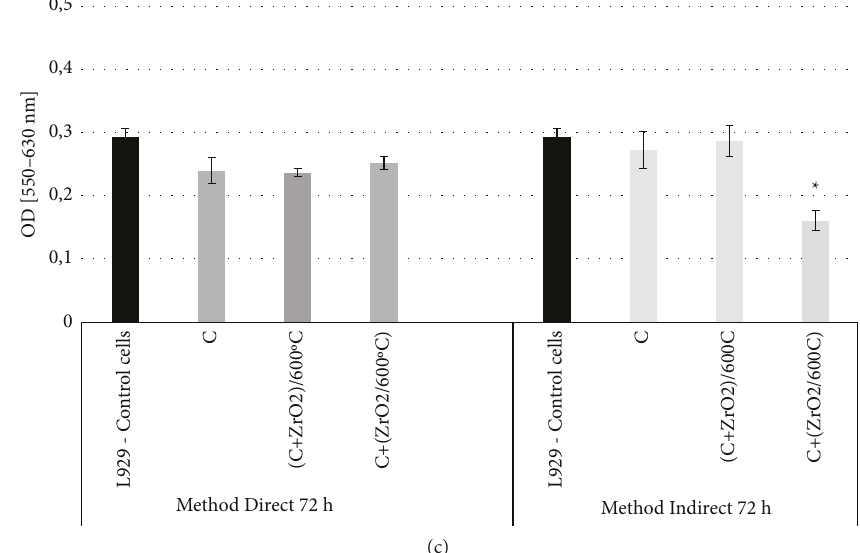
Figure 5: The cytotoxicity effect of tested cements and their eluates after direct and indirect contact on a L-929 cell culture, in vitro after incubation for (a) 24h (b) 48h, and (c) 72h Cell viability was determined with an MTTcolorimetric assay. The results of cytotoxic tests are presented as mean values of optical density (OD) at 550–630nm ± standard deviation (SD) from three separate experiments are shown; ∗ P < 0 . 05 as compared with control